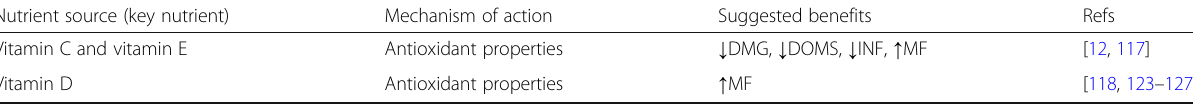
Table 5 Overview of vitamin supplements Nutrient source (key nutrient) Mechanism of